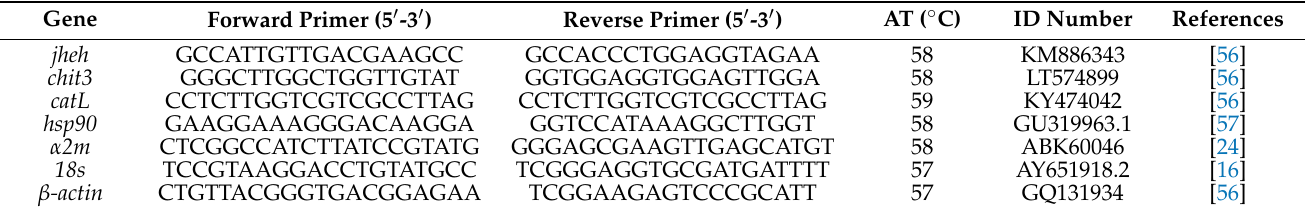
Table 3. Sequences, identification numbers, and annealing temperature (AT) of primers used in the present